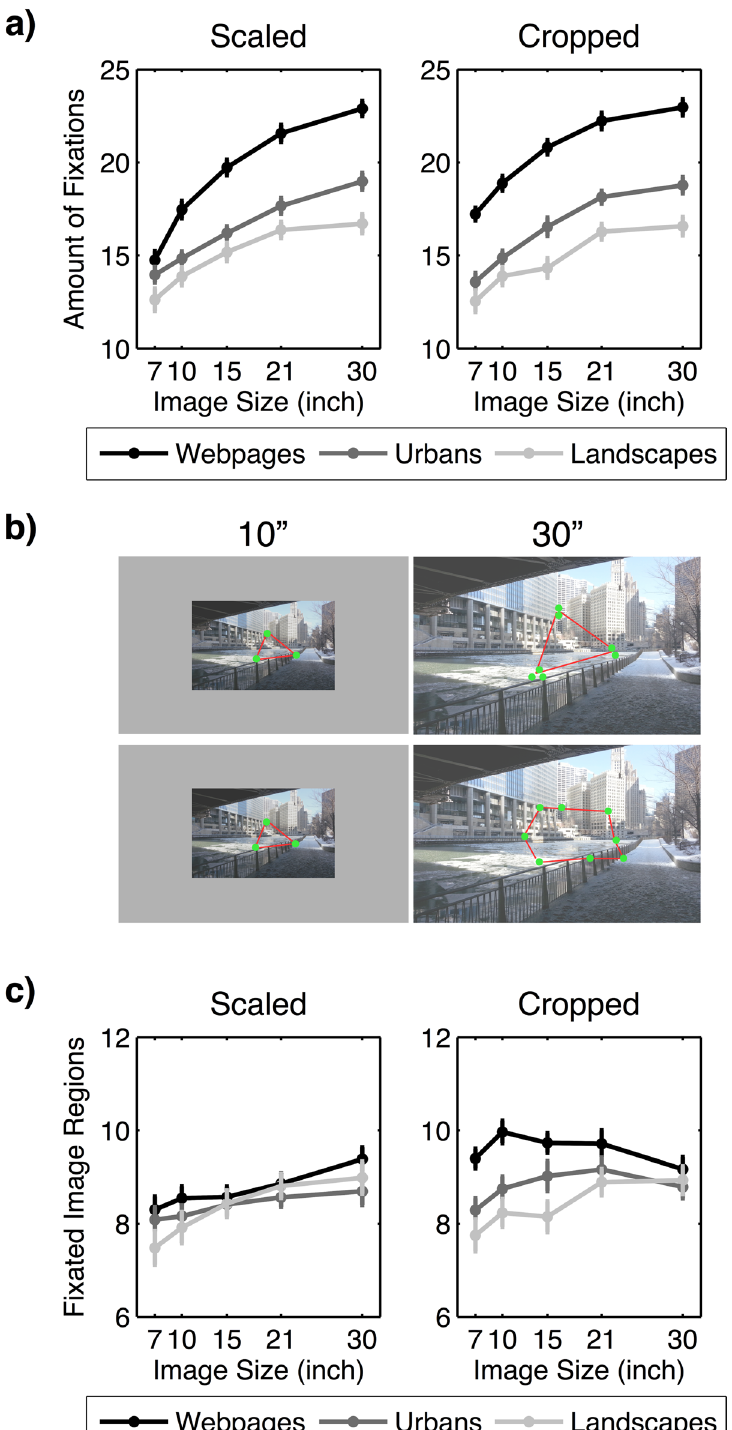
Figure 7. ( a ) Increase in the number of fixations across image sizes depending on image category for the scaled and cropped conditions. Error bars indicate the standard error of the mean. ( b ) Graphical illustration showing that a higher number of fixations on large images might have led to a re-fixation of already seen image regions (upper row) or to a spatially more extensive exploration of the image (lower row). ( c ) Mean number of fixated image regions depending on image size and image category for the scaled and cropped conditions. Error bars indicate the standard error of the